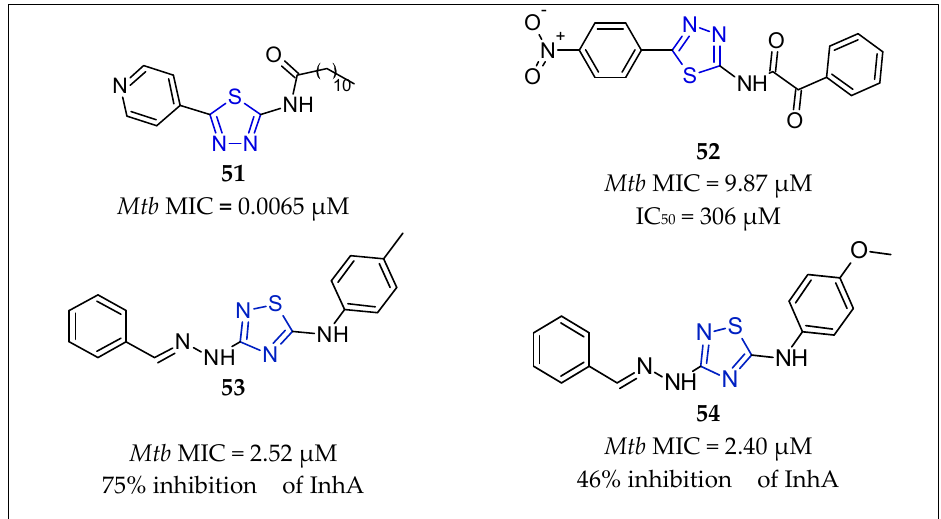
Figure 12. Chemical structures of thiadiazole-containing compounds 51 [72] , 52 [73] , 53 [12] and 54 [12] .